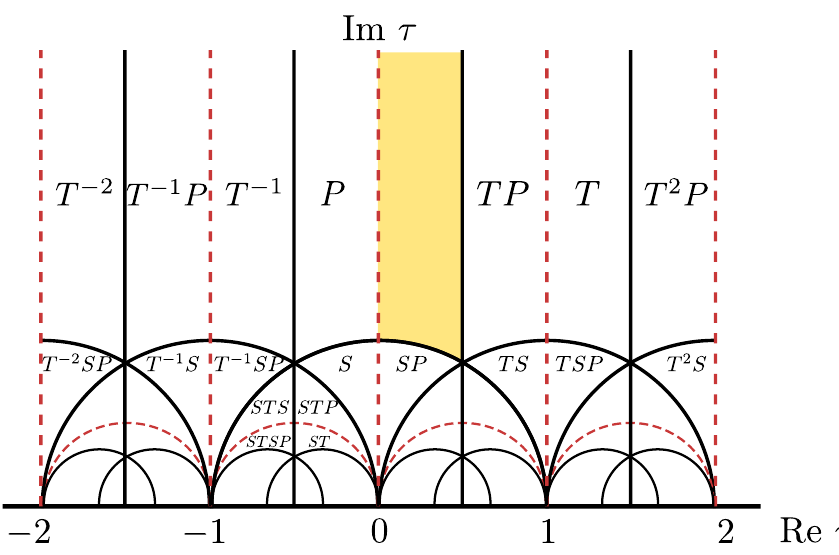
Figure 1: Fundamental domain and its images for SL ( 2, (cid:90) ) extended by parity P . New boundaries arising from the parity transformation are delineated by the dashed red